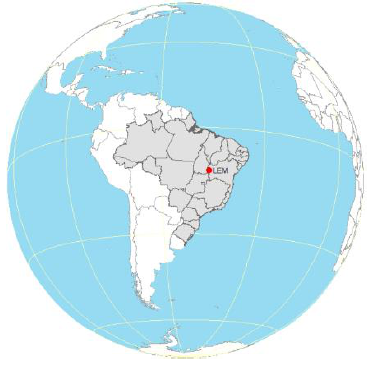
Figure 1. Location of Luís Eduardo Magalhães (LEM) municipality (red dot), in West of Bahia state,